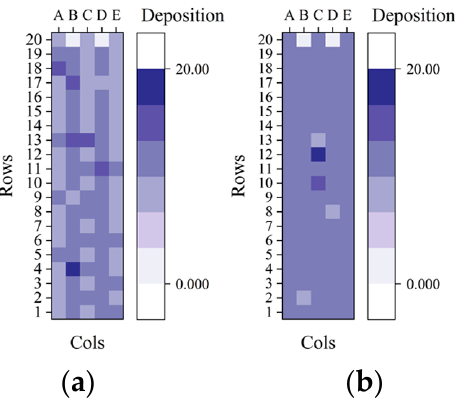
Figure 20. ( a ) Deposition of row-oriented spraying; ( b ) Deposition of full-coverage spraying.